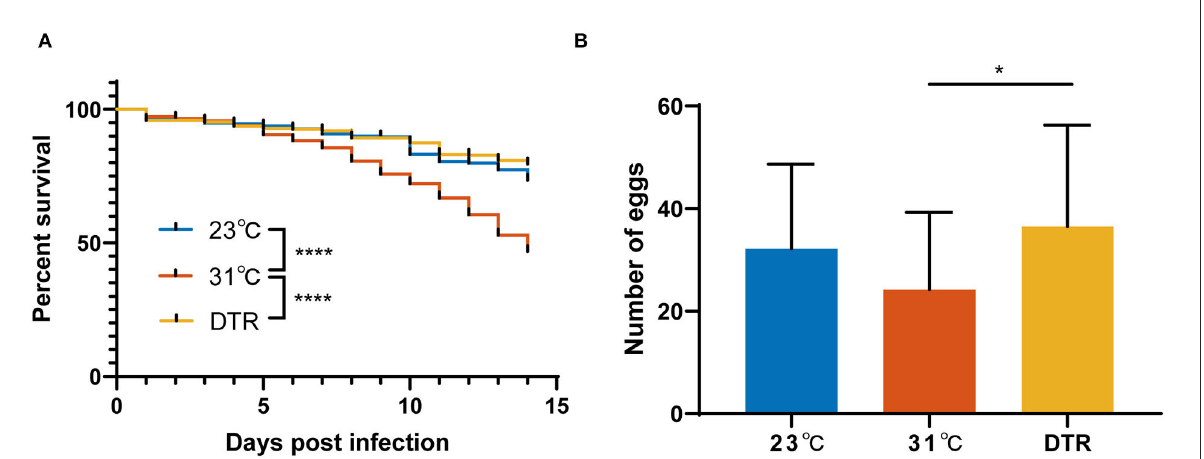
FIGURE2 Survival curves and reproduction of Ae. albopictus infected with Zika virus at different temperatures. (A) Mortality of Ae. albopictus was monitored and recorded daily after the Zika virus infection. The survival curve of each group was compared by log-rank (Mantel–Cox) test with Bonferroni correction. N = 400–500. (B) The number of eggs laid by Ae. albopictus mosquitoes after Zika virus infection. Data were presented as mean ± SD. The number of eggs was analyzed by one-way ANOVA with Holm–Sidak’s multiple comparisons test. N = 23–43. * P < 0.05, **** P <